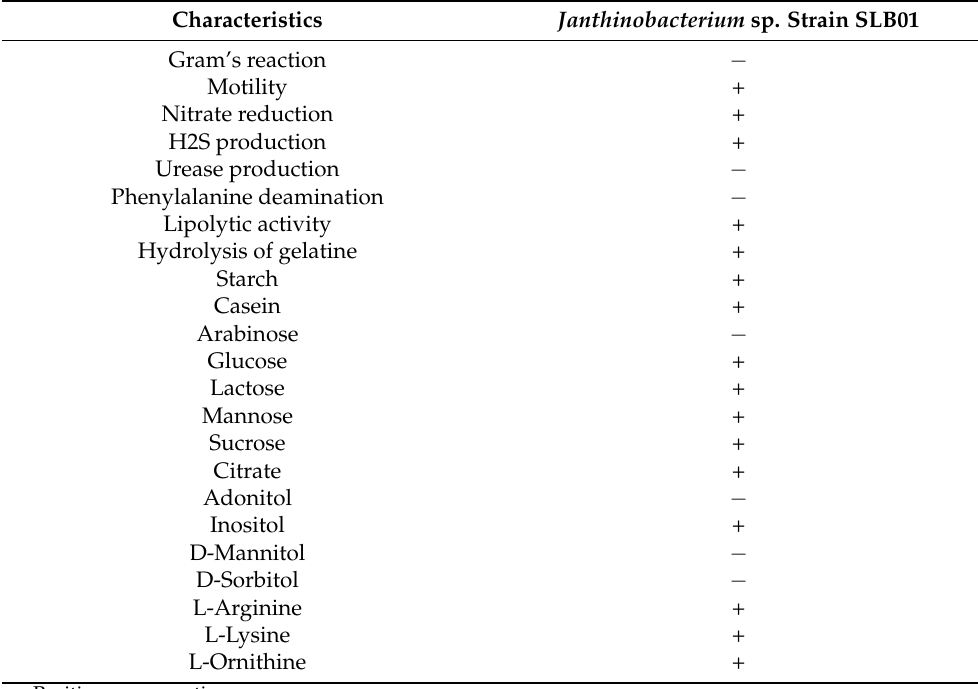
Table 1. Characteristics strain of the Janthinobacterium sp. SLB01 strain.